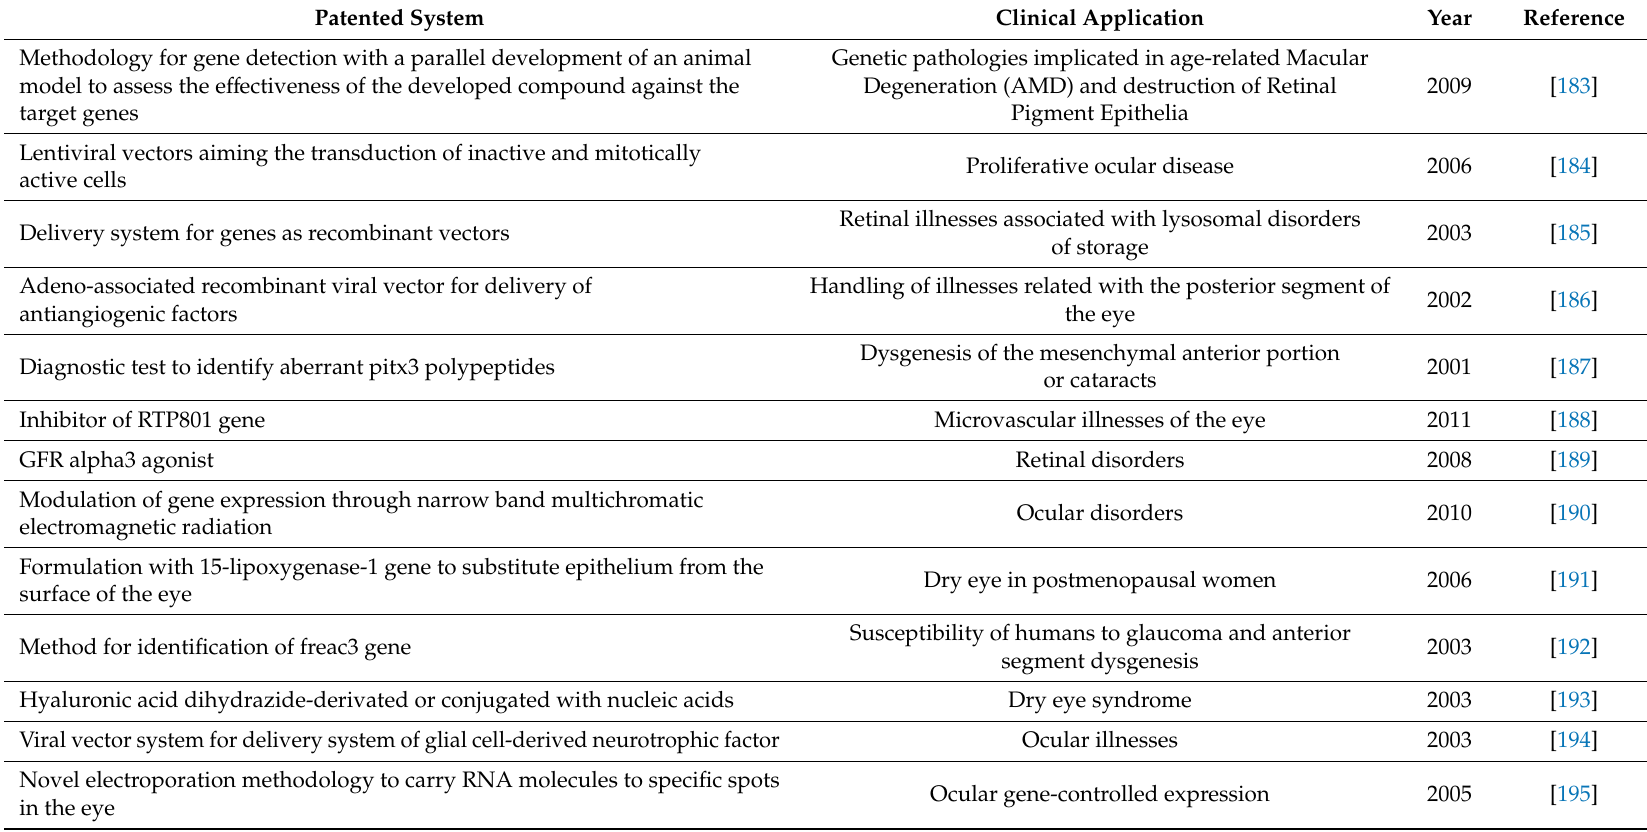
Table 4. Ocular delivery systems for gene